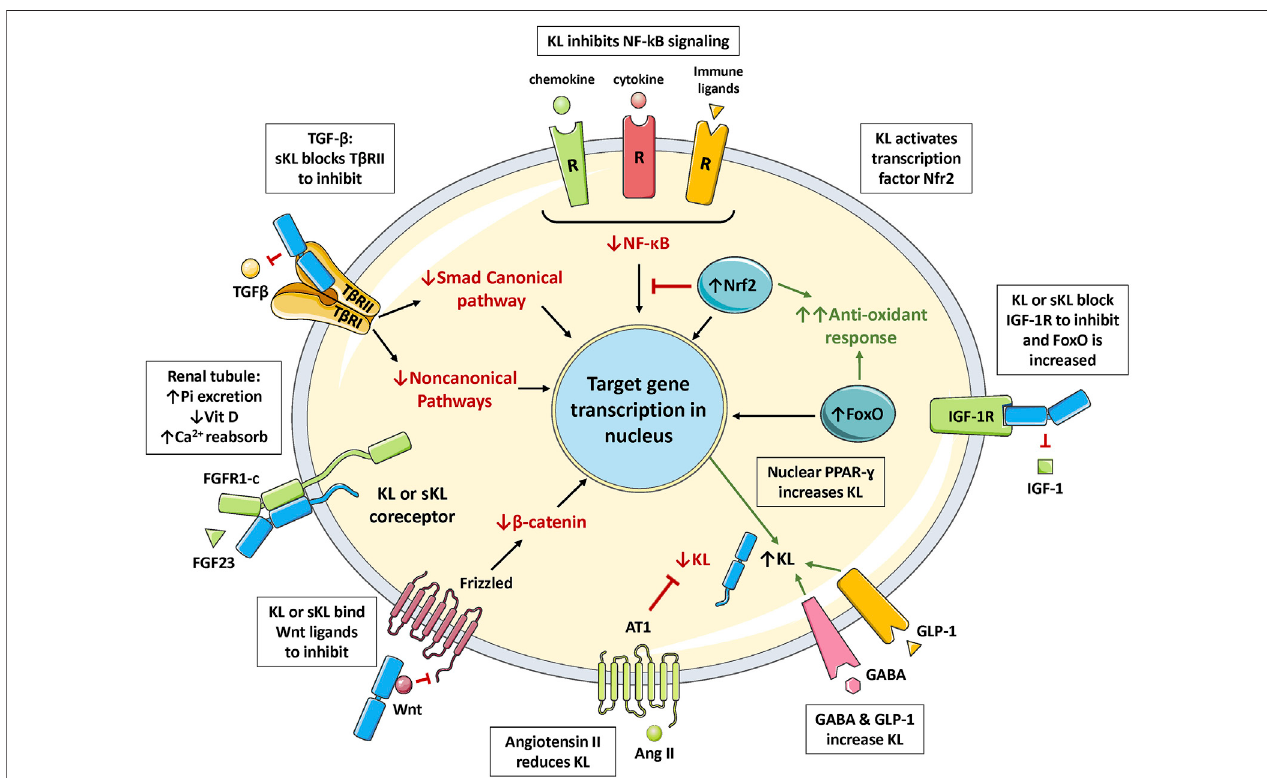
FIGURE 3 | The multiple functions of Klotho. FGF23 binds to Klotho/FGFR1c receptor in the renal tubule to increase excretion of phosphate (phosphaturic effect), regulate vitamin D metabolism, and increase calcium reabsorption. Klotho binds to the TGF- β receptor (T β RII component) to block TGF- β action. Klotho inhibits activation of the in fl ammatory NF- κ B pathway by preventing nuclear translocation of the active form. Klotho increases signaling in the Nrf2 pathway; inducing multiple antioxidant enzymesand inhibiting NF- κ B. Klotho blocks IGF-1 receptor signaling; this increases activation of FoxO and antioxidant responses. Klotho also blocks activation of the Wnt pathway by binding to soluble Wnt ligands. Klotho expression is increased by PPAR- γ activation, and also by GLP-1 and GABA stimulation; but is suppressedbyangiotensinIIactivationoftheAT1receptor.Abbreviations:AngII,angiotensinII;Ca2+,calciumion;FoxO,forkheadboxproteinO;GABA, γ -aminobutyric acid; GLP-1, glucagon-like peptide 1; IGF-1, insulin-like growth factor 1; IGFR, IGF-1 receptor; KL, membrane-bound α Klotho; NF- κ B, nuclear factor κ B; Nrf2, nuclear factor-erythroid 2-related factor 2; Pi, inorganic phosphate; PPAR- γ , peroxisome proliferator-activated receptors γ ; R, receptor; sKL, soluble α Klotho; TGF- β , transforming growth factor β ; T β RII, TGF- β receptor type II; Vit D, vitamin D.